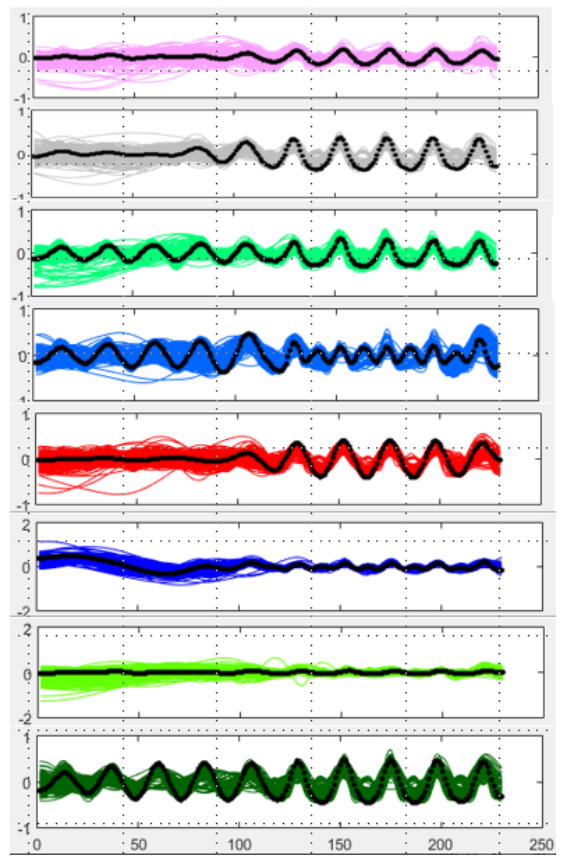
Figure 6. annual time series k-means clustering results